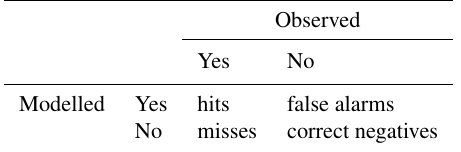
Table A1. Contingency table.